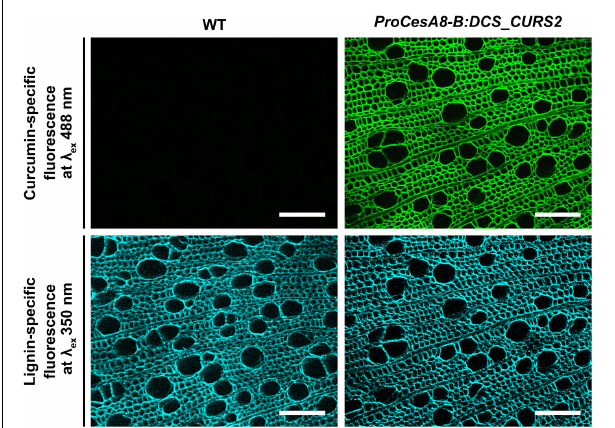
FIGURE 2 | Fluorescence microscopy on transverse stem sections of ProCesA8-B:DCS_CURS2 poplars. The curcumin-specific fluorescence signal (excitation wavelength of 488 nm) was observed in the cell wall of ProCesA8-B:DCS_CURS2 poplars, but not in that of WT poplars. The lignin-specific fluorescence (excitation wavelength of 350 nm) was observed in both the WT and ProCesA8-B:DCS_CURS2 lines. Scale bars: 100 µ